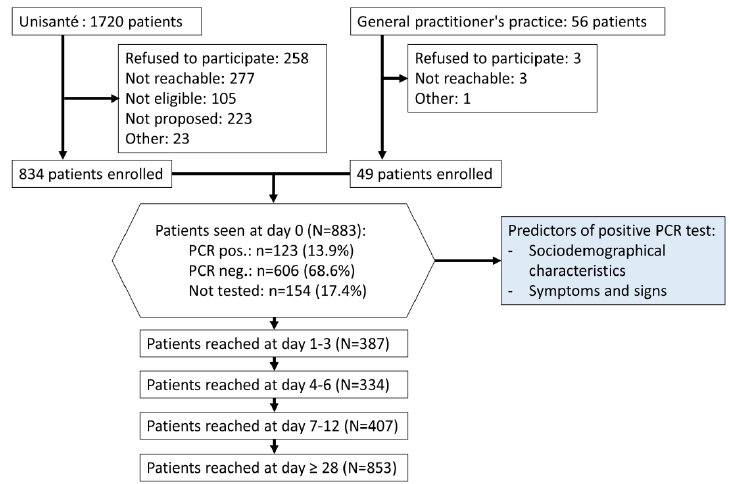
Figure 1. Flowchart of patient screening, recruitment and follow up. Unisanté includes walk-in clin- ics A and B. COVID-AMBU study, Switzerland, March – July 2020.